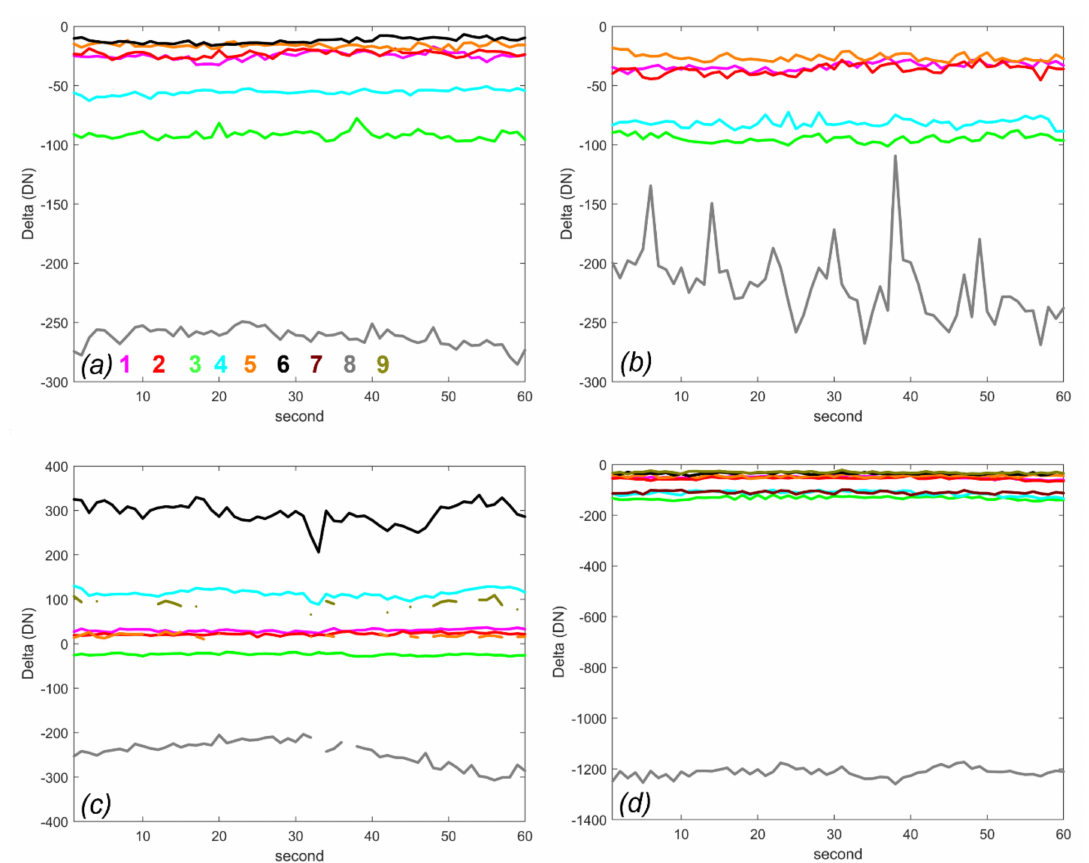
Figure A6. Delta, 1 Hz data, obtained during recording minute, using uncorrected images and DN(water) near each target, for ( a ) survey 1, ( b ) survey 2, ( c ), survey 3, and ( d ) survey 4; (derived from Figure A5). Numbers indicate targets: 1-small PET, 2-large PET, 3-EPS white, 4-EPS blue, 5-HDPE, 6-binbag, 7-tarpaulin, 8-aluminum, 9-wooden